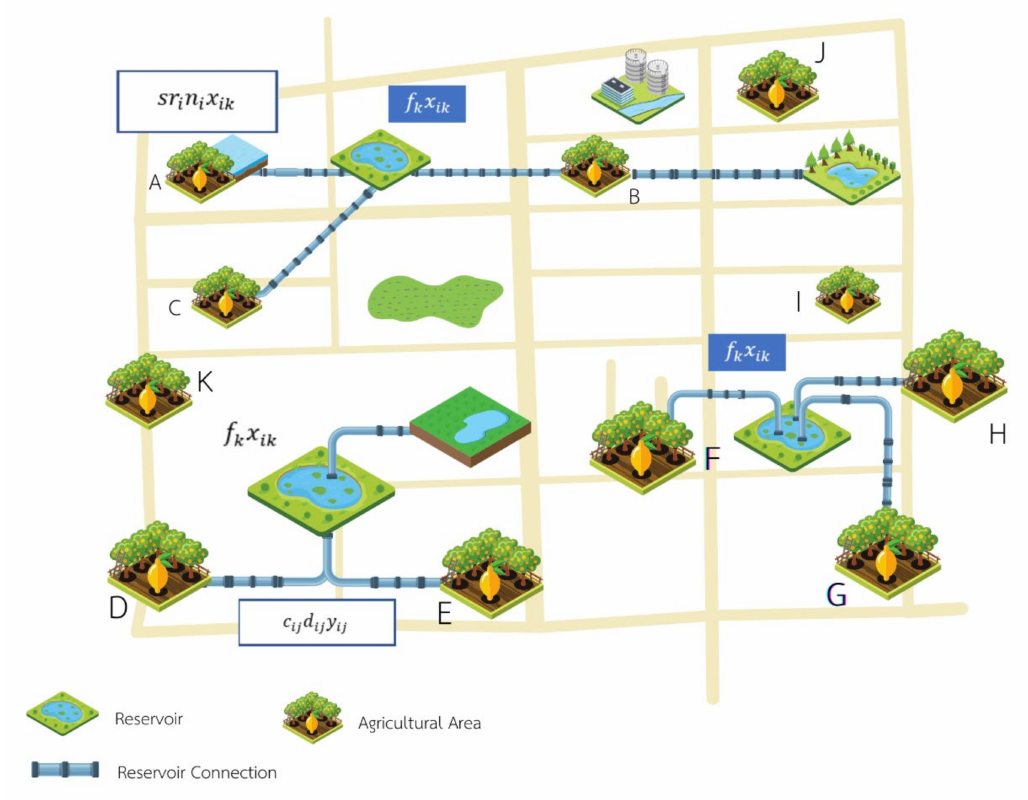
Figure 3. Graphical illustration of the proposed mathematical